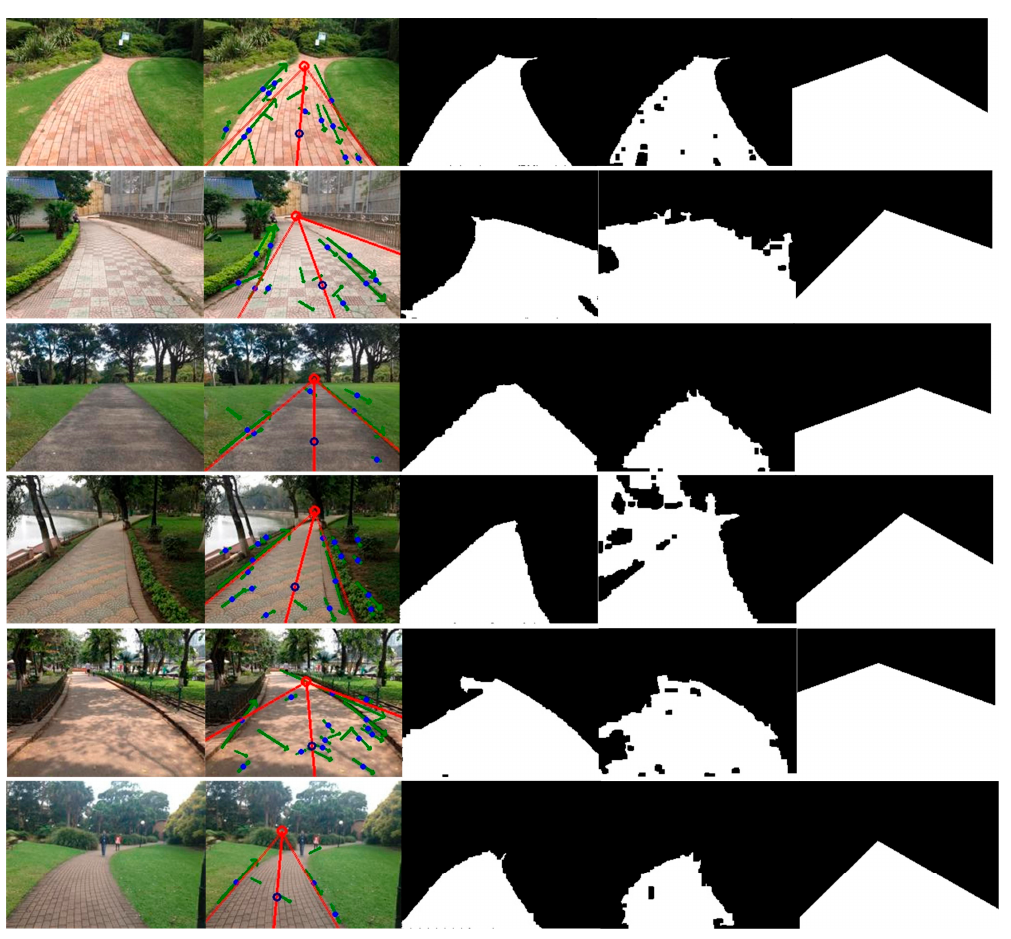
Figure 7. Examples of segmentation. Column 1: input image, Column 2: vanishing point and dominant borders detected by the proposed method, Column 3: segmentation by the proposed method, Column 4: the pixel-based method [10], Column 5: the boundary-based method [3].